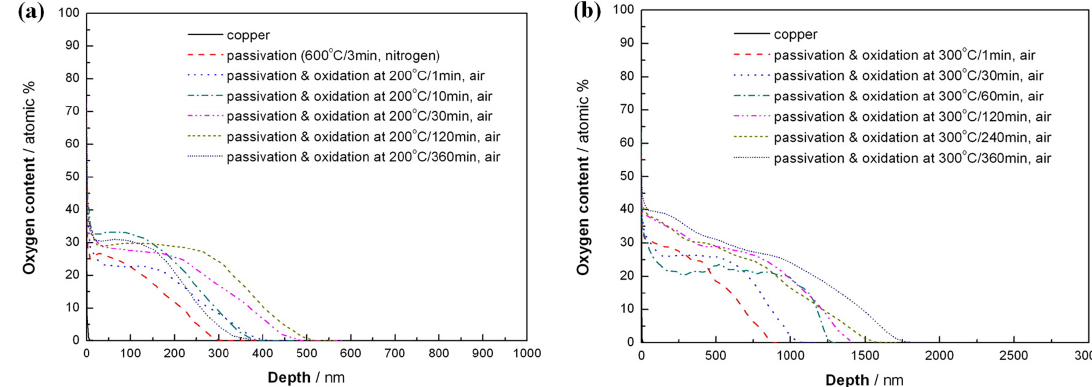
Figure 6. Oxygen profile in the passivated specimen after oxidation at (a) 200 °C and (b) 300 °C in air for various durations